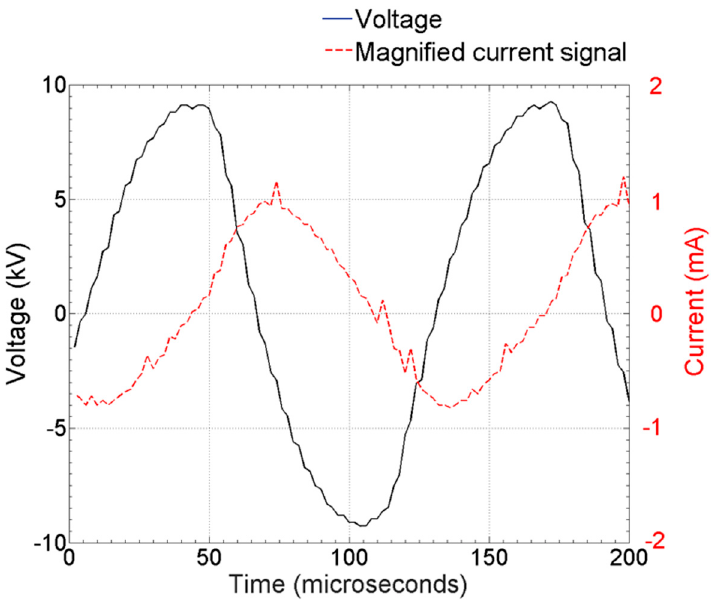
Figure 3. Voltage and magnified current output waveform at 18 kV peak-to-peak and 8 kHz.